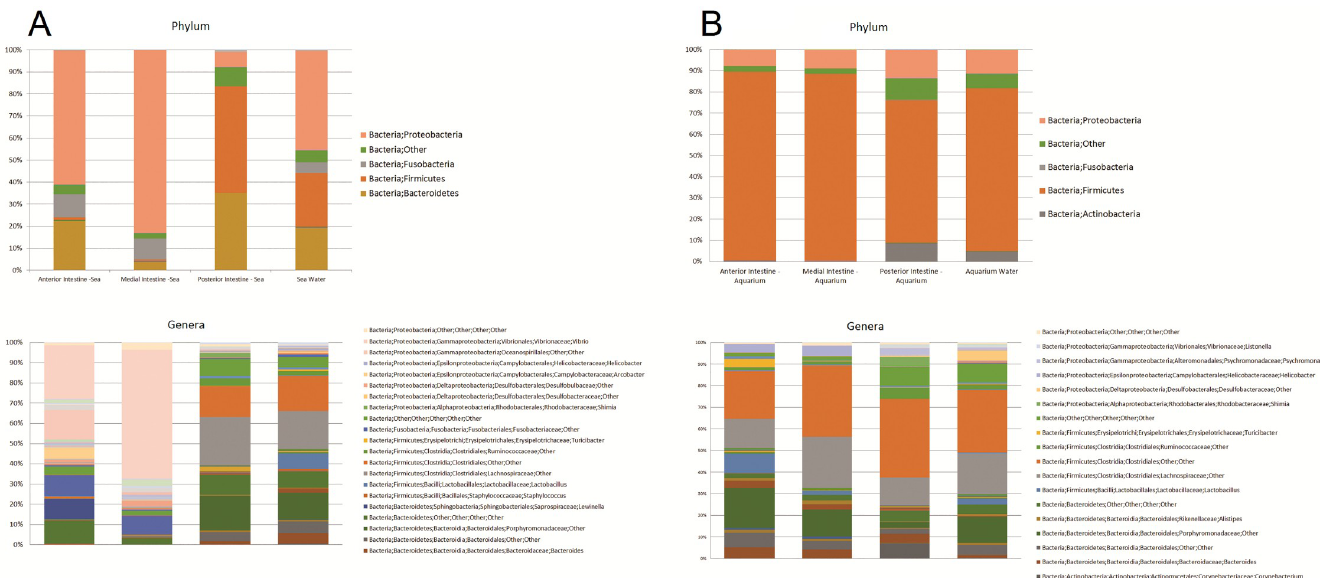
Fig 2. Bacterial taxa distribution in the intestinal system of H . glaberrima . (A) Phylum and Genera of intestinal bacterial OTUs of animals in the sea (natural environment). B) Phylum and Genera of intestinal bacterial OTUs of animals in seawater tanks (aquarium environment).